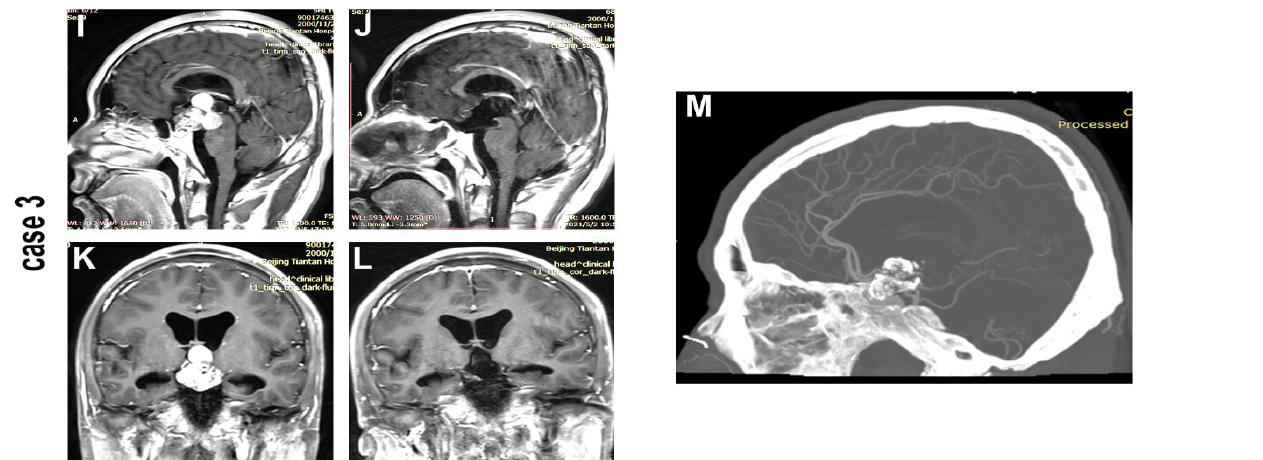
Figure 2. The application of EETS in resecting craniopharyngioma. Case 1 patient with preoperative hypothalamic involvement had improved hypothalamic involvement after EETS. Preoperative sagittal ( A ) and coronal ( C ) MR T1-weighted images showed tumor invasion of the hypothalamus; postoperative sagittal ( B ) and coronal ( D ) MR T1-weighted images showed the integrated hypothalamus. Case 2 patients with giant craniopharyngioma underwent gross total resection (GTR) using EETS. Preoperative sagittal ( E ) and coronal ( G ) MR T1-weighted images showed craniopharyngioma of giant size; postoperative sagittal ( F ) and coronal ( H ) MR T1-weighted images showed the GTR. Case 3 patients with calcified craniopharyngiomas underwent GTR using EETS. Preoperative sagittal ( I ), coronal ( K ) MR T1-weighted images, and preoperative sagittal ( M ) computed tomography images showed the craniopharyngioma possessed calcification; postoperative sagittal ( J ) and